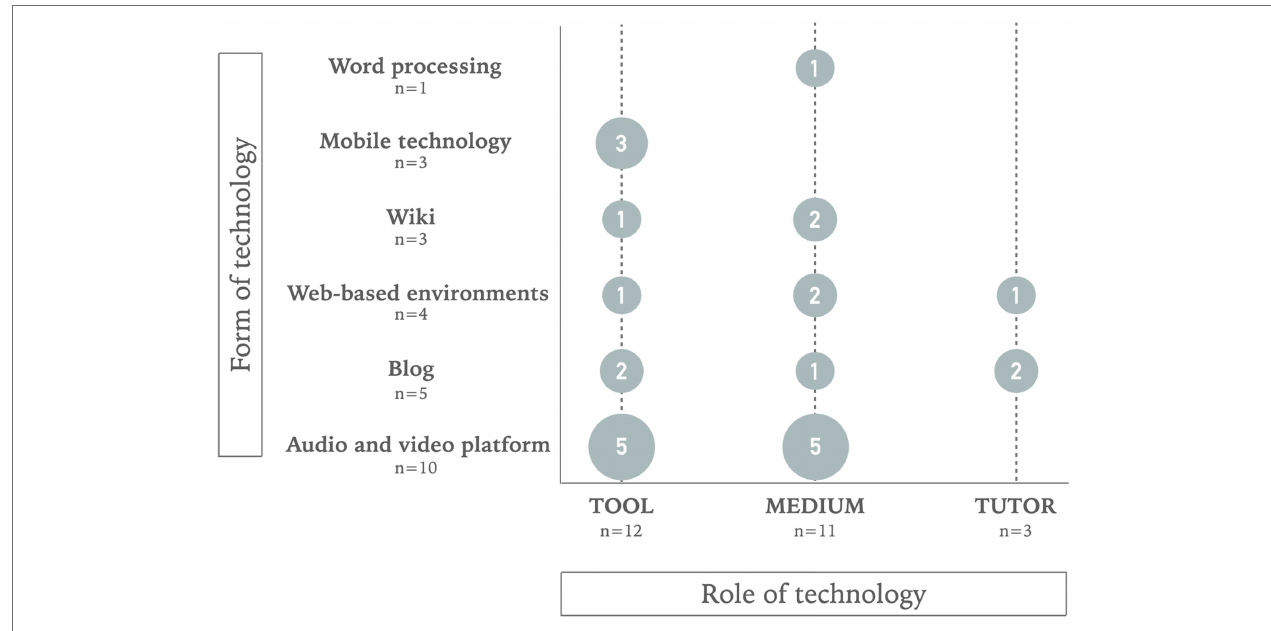
FIGURE 2 | Form and role of the